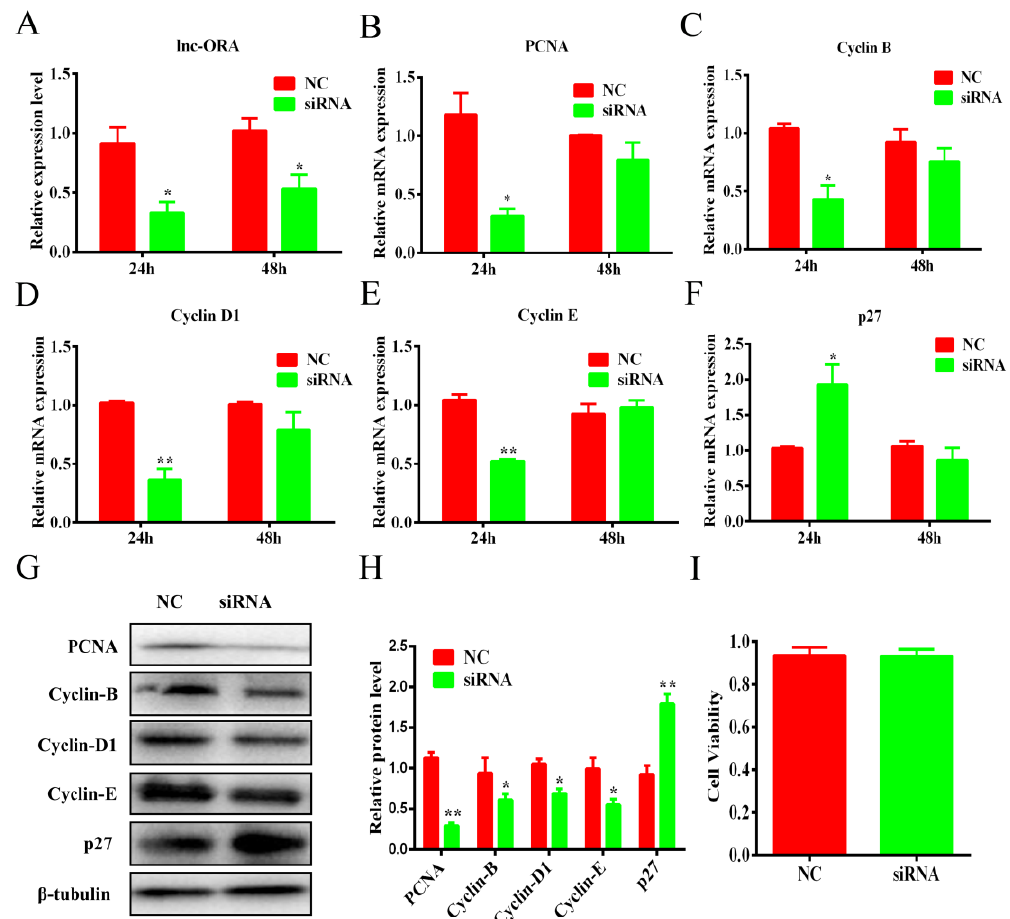
Figure 6. Knockdown of lnc-ORA downregulates the expression levels of cell cycle genes. ( A ) Knockdown efficiency of lnc-ORA after preadipocytes transfection for 24 h and 48 h. ( B – F ) The mRNA expression of cell cycle marker genes PCNA, cyclin B, cyclin D1, cyclin E , and p27 was detected by qPCR. ( G ) Protein expression of cell cycle marker genes PCNA , cyclin B, cyclin D1 , cyclin E , and p27 was detected by Western blot. ( H ) Protein quantitative analysis of PCNA, cyclin B, cyclin D1, cyclin E, and p27. ( I ) CCK-8 analysis of cell viability of transfected preadipocytes. Data are expressed as the mean ± SEM (n = 3). * p < 0.05, ** p < 0.01, vs. NC.